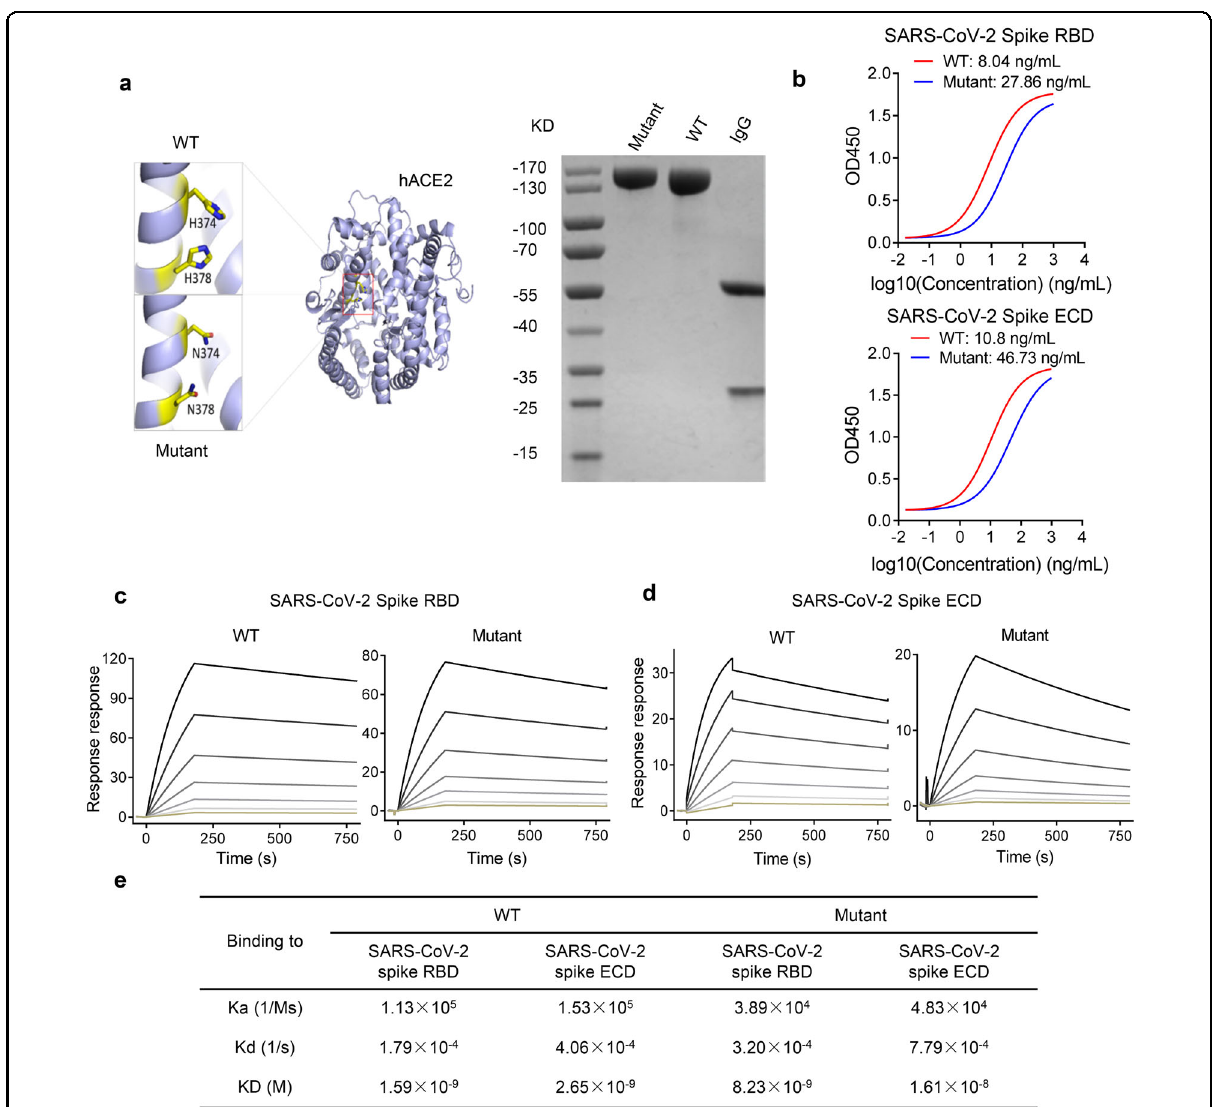
Fig. 1 Expression, binding, and af fi nity of hACE2-Fc. a Diagrams of protein structure model and SDS-PAGE analysis of hACE2-Fc WT and hACE2-Fc mutant. b Binding speci fi city of hACE2-Fc WT and hACE2-Fc mutant. 96-well plate was coated with protein SARS-CoV-2 RBD and S, respectively (0.5 μ g/mL), and serially diluted hACE2-Fc was added. HRP-labeled mouse anti-human IgG-Fc antibody was used as ELISA secondary antibody. Three independent experiments were performed, of which one representative result was shown. c, d hACE2-Fc show a potent binding to SARS-CoV-2 Spike ECD and RBD in Biacore assay. SARS-CoV-2 Spike ECD and RBD was immobilized on the chip surface, followed by injecting diluted analytes (hACE2-FC WT: 1.14 nM, 2.28 nM, 4.56 nM, 9.12 nM, 18.25 nM, 36.5 nM, 73 nM; hACE2-Fc mutant: 1.5625 nM, 3.125 nM, 6.25 nM, 12.5 nM, 25 nM, 50 nM, 100 nM, 200 nM) as association phase and injecting running buffer as dissociation phase (Biacore 8 K, GE Healthcare). All the data were processed using the Biacore 8 K Evaluation software version 1.1. e Summary of SPR assay. Association constant (Ka), dissociation constant (Kd) and equilibrium dissociation constant (KD) of hACE2-Fc (WT and mutant) against Spike ECD and RBD were calculated by Biacore 8 K. KD calculated as Ka/Kd, a smaller